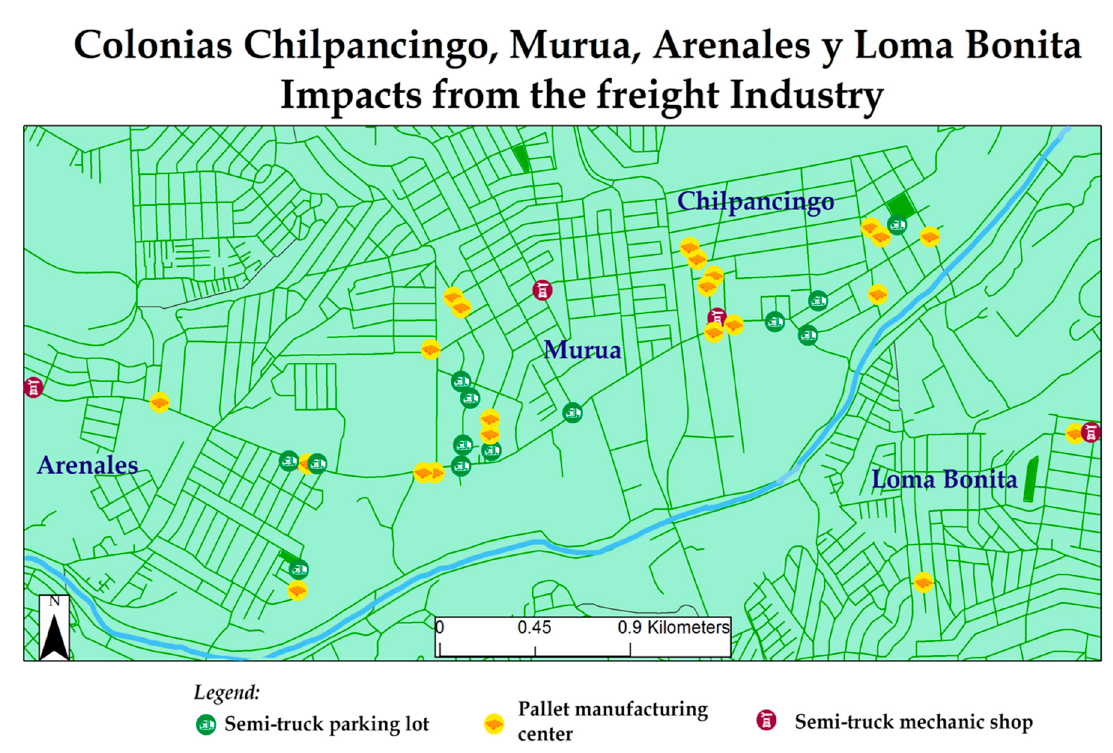
Figure 5. Colectivo region freight industry impacts.